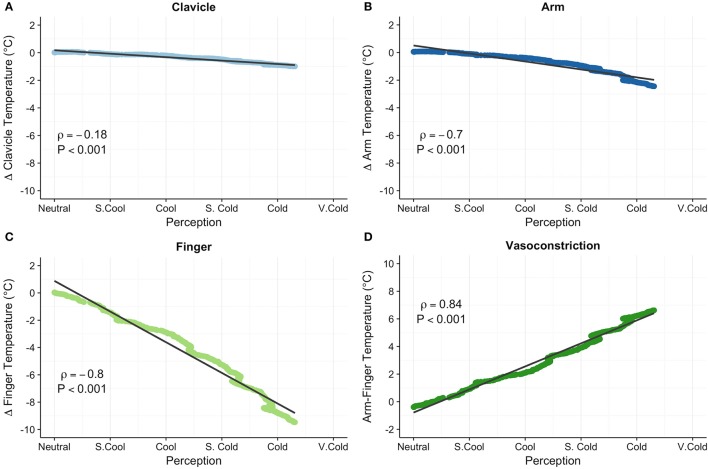
Clavicle (°C; A), forearm (°C; B), finger (°C; C), and peripheral vasoconstriction (forearm–finger, °C; D) skin temperatures correlated with subjective perception of cooling ratings. Relative clavicle, forearm, and finger skin temperatures are expressed as the change (Δ) in temperature from the end of the thermoneutral phase. Least squares best-fit lines are overlaid on the temperature data, which were linearly interpolated and averaged among participants. Small upward fluctuations in the temperature gradient (most notable in the finger skin temperature) were the result of two volunteers indicating a warmer perception rating when water temperature was adjusted (i.e., a brief stop of circulating cold water). Correlation (ρ) between temperature and perception was evaluated with the Spearman rank test.